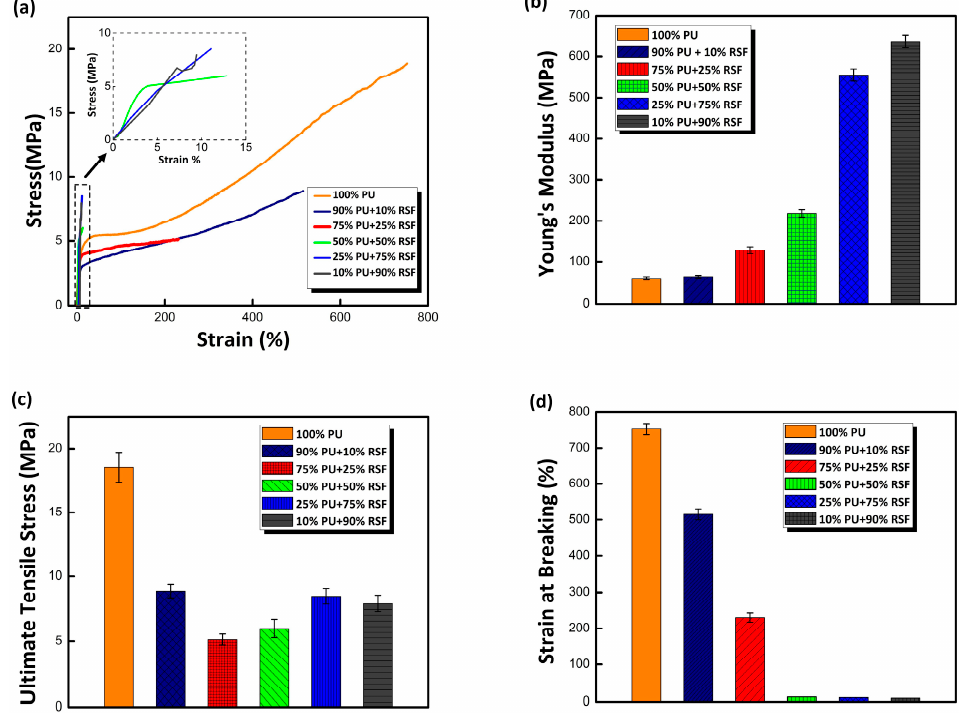
Figure 5. Tensile properties of PU/RSF blended fibres: ( a ) Stress–strain curves of PU/RSF composite fibres. The blend composition of 75/25 exhibits FTSS properties. The stress–strain curves with significantly less strain values are displayed in insets. ( b ) Young’s modulus of PU/RSF composite fibres. The increase in RSF component improved young modulus of fibres significantly ( c ) Ultimate tensile stress of PU/RSF composite fibres. The 100% PU represents highest tensile stress values than PU/RSF blended fibres. ( d ) Strain at breaking (%) of PU/RSF fibres. The increase of crystalline domains in amorphous PU matrix has reduced the strain at break of fibres significantly.